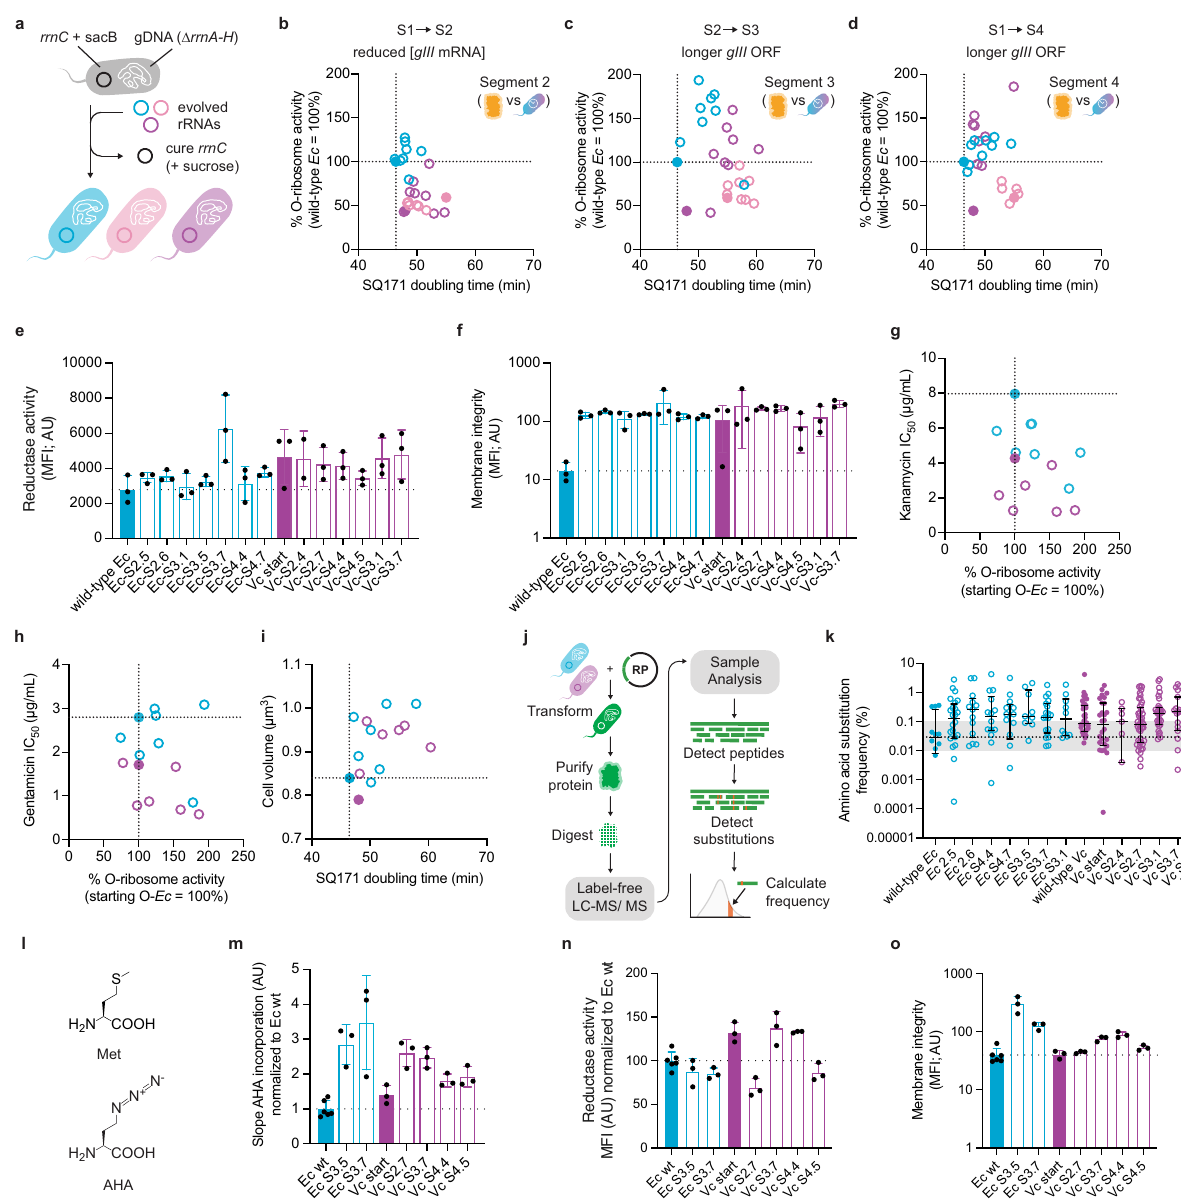
Fig. 6 Evolved rRNAs support proteome-wide translation at elevated levels. a The o-RBS of oRibo-PACE-derived rRNA variants was substituted with the wild-type RBS, and used to complement SQ171 strains (resident plasmids cured by sucrose selection). O-ribosome luminescence activity plotted against complemented SQ171 strain doubling times for all species corresponding to selections segment: b S1 → S2, c S2 → S3, and d S1 → S4. Data re fl ect a mean of 1 – 72 biological replicates ( n = 1 – 72). Select rRNA variants were prioritized based on luminescence activity and evaluated for cellular characteristics: electron transport chain function as assessed through cellular reductase activity ( e ) and membrane integrity as assessed through propidium iodide entry ( f ). Data represent mean fl uorescence intensity (MFI) with the error shown as the standard deviation of three biological replicates ( n = 3). SQ171 strain sensitivity to the mistranslation-promoting aminoglycosides kanamycin ( g ) and gentamicin ( h ) negatively correlates evolved o-ribosome activity. i Complemented SQ171 strains show increased volume concomitant with observed increases of the population doubling time. j Schematic representation of the work fl ow used to analyze amino acid mistranslation rates through sfGFP puri fi cation and LC – MS/MS analysis. k The amino acid substitution frequency of select rRNA variants via sfGFP expression, shown as a % of total amino acid detected at a given position. Data re fl ect sfGFP puri fi ed from six pooled biological replicates ( n = 6). Each point represents an identi fi ed amino acid substitution, the horizontal bar represents the median substitution frequency of all misincorporations detected in the sample, and the distribution shown as the interquartile range. The gray bar represents average cellular amino acid mis-incorporation limits. l The methionine (Met) analog L -azidohomoalanine (AHA) was used to determine proteome-wide translation rate through unbiased cellular incorporation. m Mean slope of AHA incorporation calculated from 20-min time-course analysis. Data normalized to mean slope of wild- type E. coli from each experimental run. n Complemented SQ171 cells show similar reductase activity and o membrane integrity during the AHA incorporation assay. Data re fl ect the mean and standard deviation of three biological replicates run on different days ( n = 3). Where relevant, data are normalized to the activity of the starting E. coli o-rRNA activity, this is represented as a dashed line. Starting rRNAs are shown as fi lled in bars or circles, whereas evolved variants are shown as borders only. Colors blue ( E. coli ), pink ( P. aeruginosa ), and purple ( V. cholerae ) are consistent across plots. Source Data are available in the Source Data